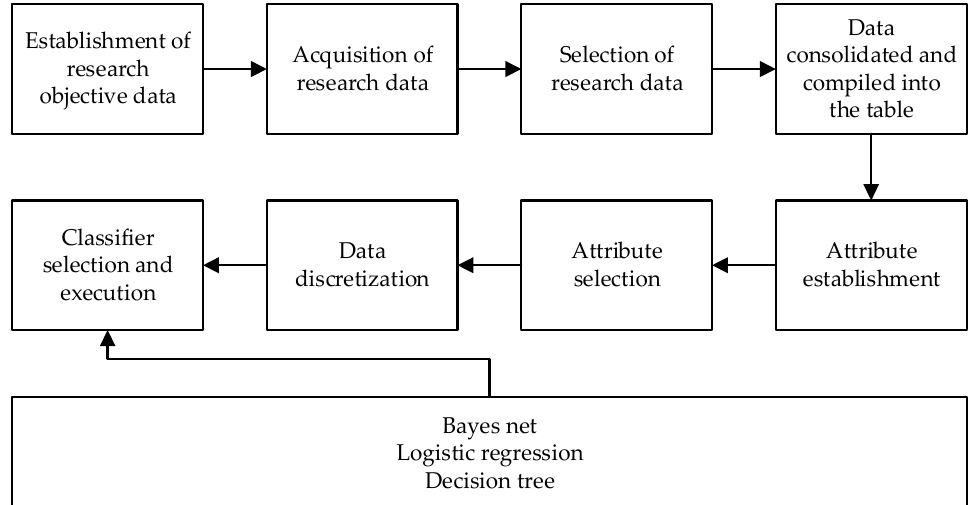
Figure 1. Research framework.